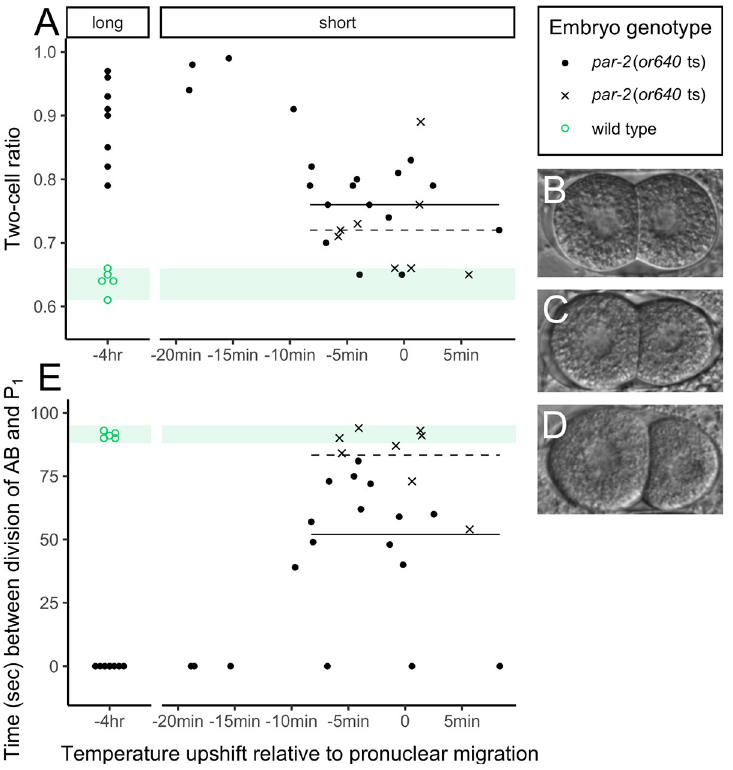
Fig 3. Penetrance and expressivity of a par-2 temperature sensitive mutation. (A) At the two-cell stage, par-2 ( or640 ts) embryos exposed to the restrictive temperature in a long upshift (4hrs) or in a short upshift begun at least 9min before pronuclear migration exhibit substantial loss of asymmetry. The range of ratio values for wild type embryos is highlighted in green. (B) Two-cell par-2 ( or640 ts) embryo with extreme loss of asymmetry (ratio = 0.91). (C) Two-cell par-2 ( or640 ts) embryo with intermediate loss of asymmetry (ratio = 0.81). (D) Wild type embryo (ratio = 0.64). (E) In the transition from two to four cells, embryos upshifted 10min or more before pronuclear migration show complete synchrony in the timing of the division of AB and P 1 cells, whereas those upshifted later more often show an intermediate time interval between cell divisions. In both plots, long upshift points were jittered on the x-axis for visualization, and x’s indicate embryos that were processed without the use of the temperature control device. The horizontal lines indicate average phenotype values for embryos processed with (solid) or without (dashed) the device, over their shared